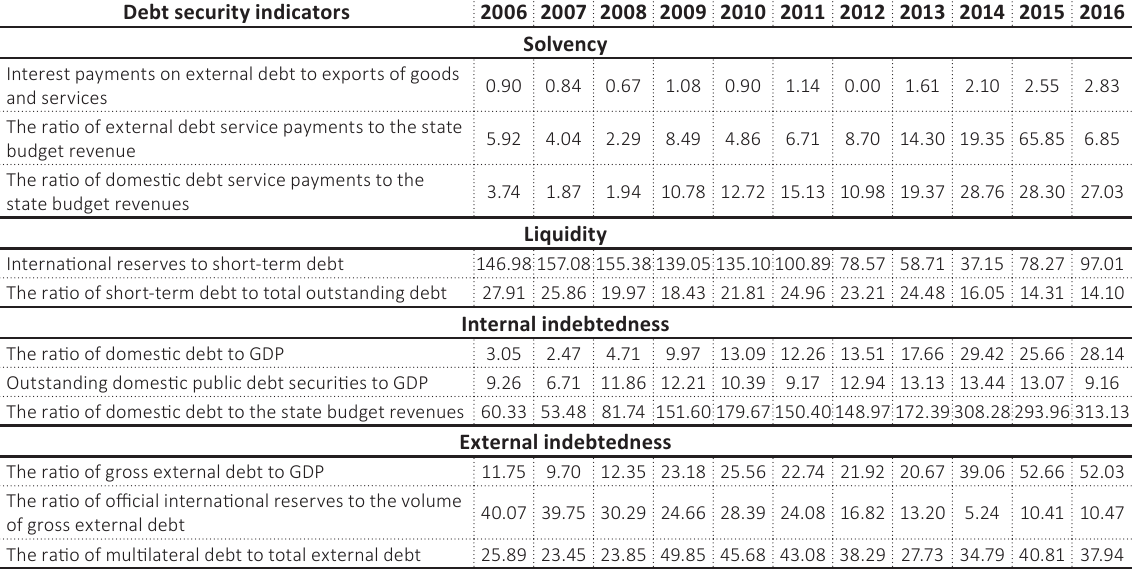
Table B1. Results of calculation of the debt security indicators (authors’ approach)